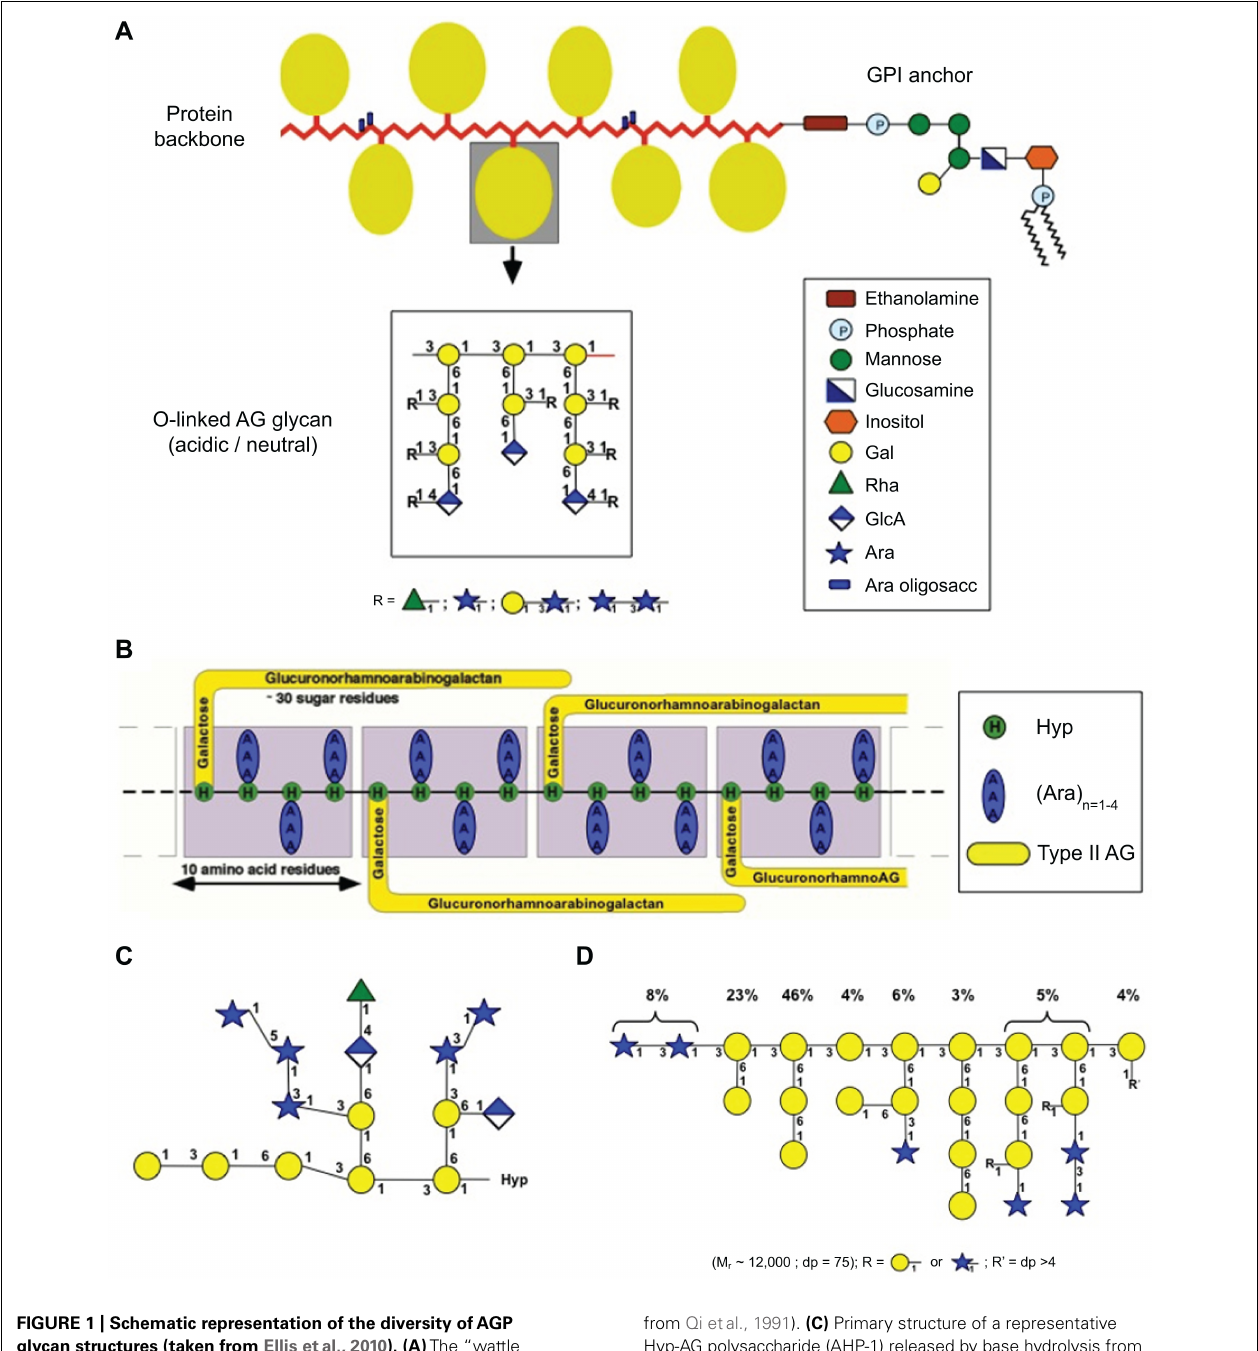
FIGURE 1 | Schematic representation of the diversity ofAGP glycan structures (taken from Ellis etal., 2010). (A) The “wattle blossom” model of the structure of AGPs with a GPI-membrane anchor attached (modified from Fincher etal., 1983). (B) The “twisted-hairy rope” model of the structure of the Gum Arabic glycoprotein (GAGP;